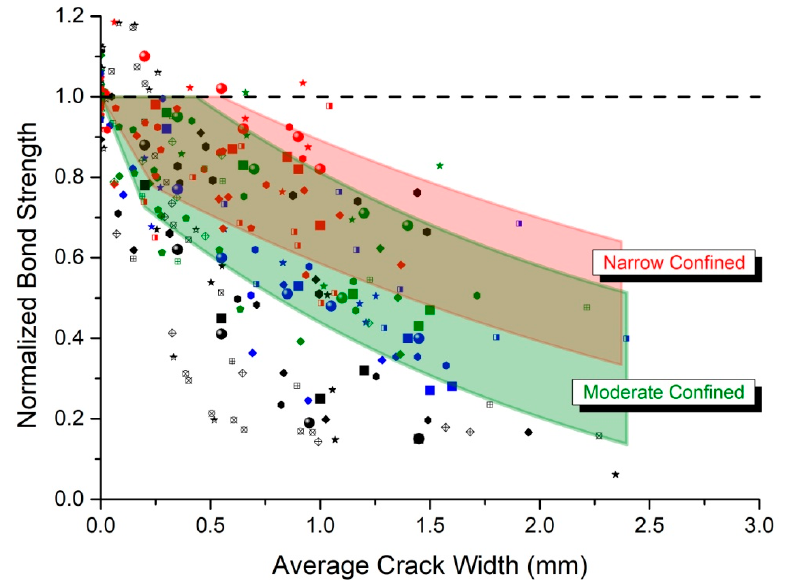
Figure 13. Proposed predictive zones of bond loss in relationship to crack width—in the case of modern designed structures.